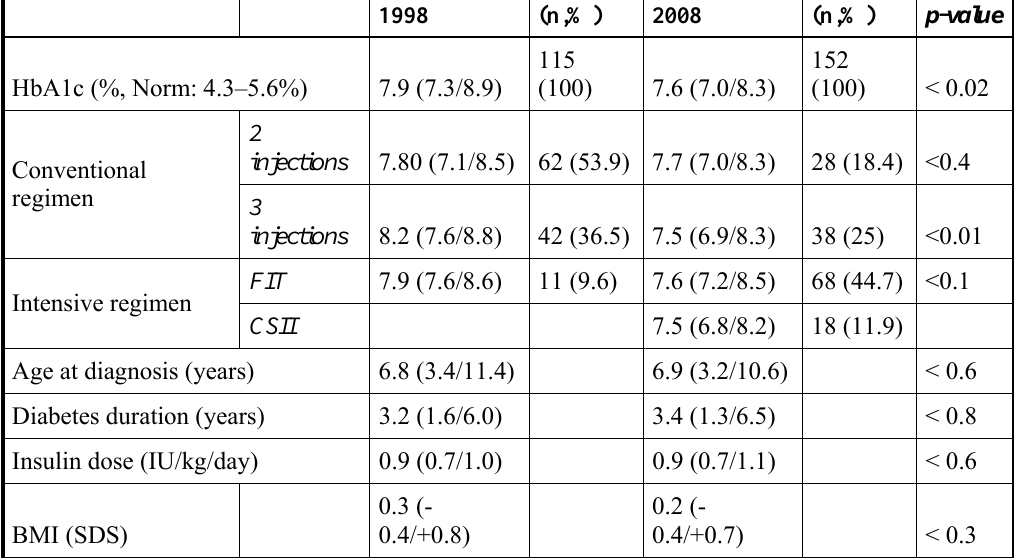
Comparative statistics between the 1998 and 2008 study population.